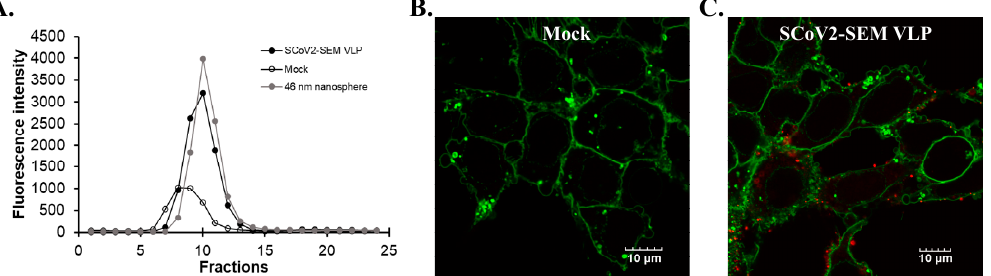
Figure 4. The generation of the Atto647N-tagged SCoV2-SEM VLPs. ( A ) Fluorescence intensity profiles of elution from a Sephadex G-25 size-exclusion column were shown. The signals of Atto647N- tagged SCoV2-SEM VLPs were indicated as black circles. Background signals were detected in SCoV2-SEM VLP-free medium (white circles). The signals of 46 nm nanospheres were shown in gray circles. ( B , C ) The confocal microscopy images of HEK293T-ACE2 cells incubated with atto647N fractions from SCoV2-SEM VLP-free medium ( B ) or medium with Atto647N-tagged SCoV2-SEM VLPs. ( C ) Fluorescent images of SCoV2-SEM VLPs were indicated in red. Scale bar, 10 μ m.